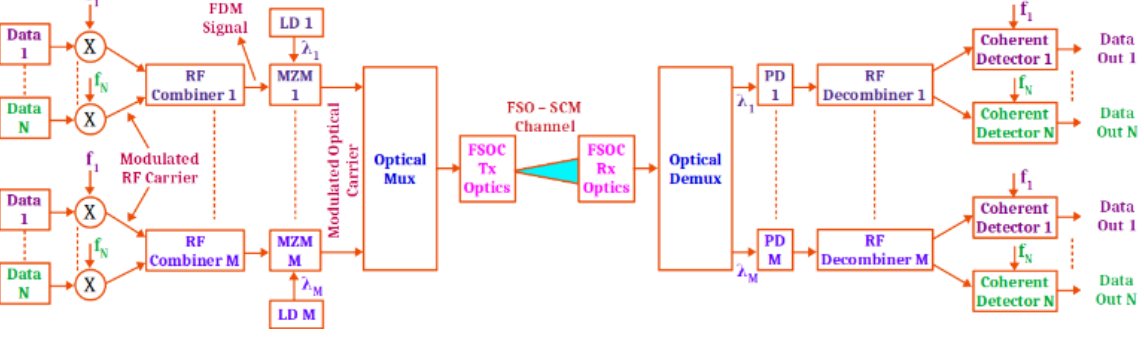
Figure 24. Schematic of SCM-based FSO system.